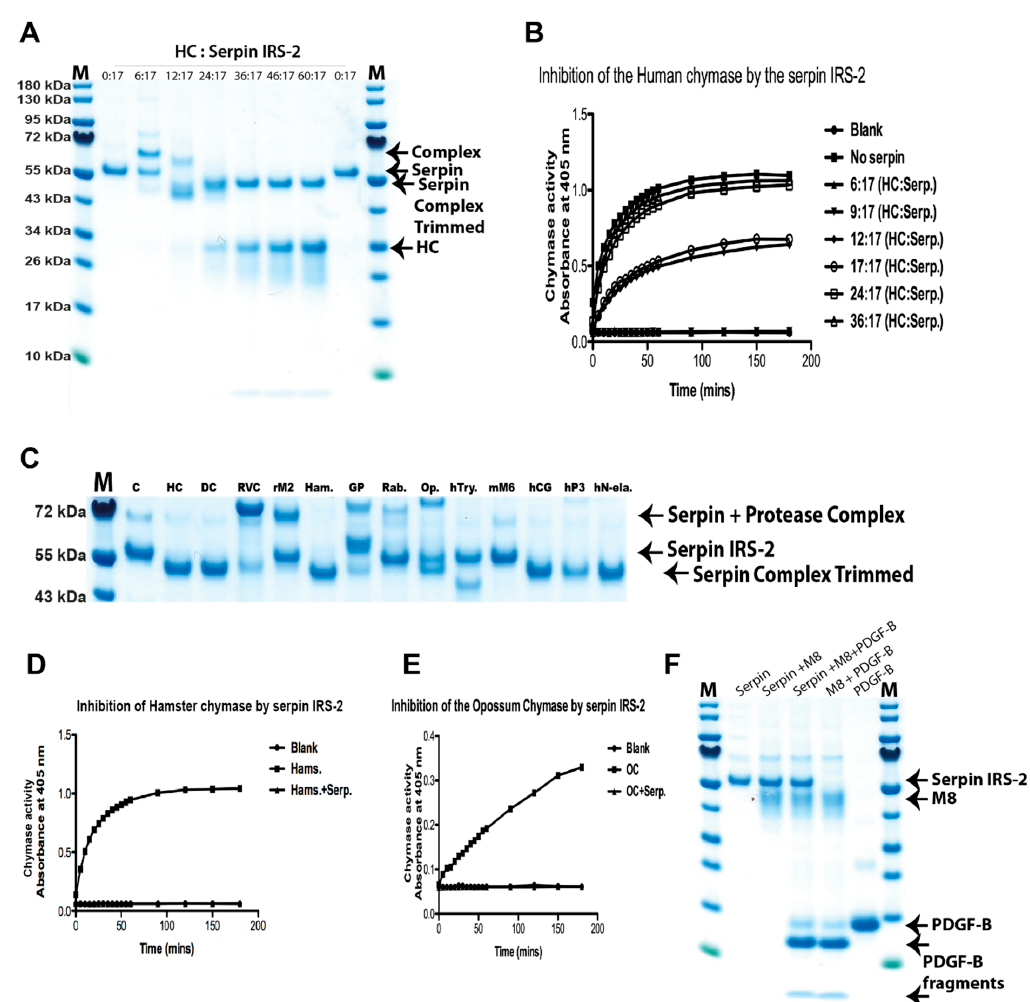
Figure 3. Inhibiting activity of the tick serpin IRS-2 on a panel of mammalian hematopoietic serine proteases. Panel ( A ) shows a titration of the activity of tick IRS-2 on human mast cell chymase. The amount of the recombinant tick IRS-2 was constant in all lanes. The amount of human chymase increased from left to right, starting and ending with two lanes with no chymase to show the size and purity of the recombinant IRS-2 and a reference point to evaluate the different complexes and cleavage products that appear following the interaction between the serpin and the enzyme. The ratio is then presented as follows. No chymase and 17 molar equivalents IRS-2 (0:17), six molar equivalents chymase and 17 equivalents IRS-2 (6:17) and until (60:17). The covalent serpin-chymase complex, the serpin, the trimmed serpin chymase complex and the unbound chymase are all marked by arrows to the right side of the panel ( A ). Panel ( B ) shows a chromogenic substrate assay of the different samples shown in Figure 3A using a chromogenic substrate (Suc-AAPF-pNA) for chymotrypsin-like proteases. In a ratio where the remaining free chymase starts to appear in panel ( A ) (12:17), cleavage of the substrate is also starting. Panel ( C ) shows an analysis of the inhibiting activity of a panel of hematopoietic serine proteases ranging from human to platypus enzymes, the same as in Figure 2, except mMCP-8, which is analyzed in panel ( F ). All proteases in this panel are inhibited by the serpin except for the rabbit Leu-ase and the tryptases, human tryptase and mMCP-6. The covalent serpin-enzyme complex, the serpin and the trimmed serpin protease complex are marked by arrows to the right side of the panel ( C ). Panels ( D , E ) show the activity of the serpin on hamster and opossum chymases using a chromogenic substrate. The panels also indicate that the trimmed complexes, seen in panel ( C ), are enzymatically inactive due to the serpin that is covalently bound to the active site of the enzymes. Panel F shows the potential interaction between the serpin and mMCP-8. mMCP-8 is not inhibited by IRS-2 and can cleave the substrate mouse PDGF-B even in the presence of the serpin. The serpin, mMCP-8, uncleaved mouse PDGF-B, and the two fragments of mouse PDGF-B generated after cleavage by mMCP-8 are all marked by arrows to the right side of the panel ( F ).